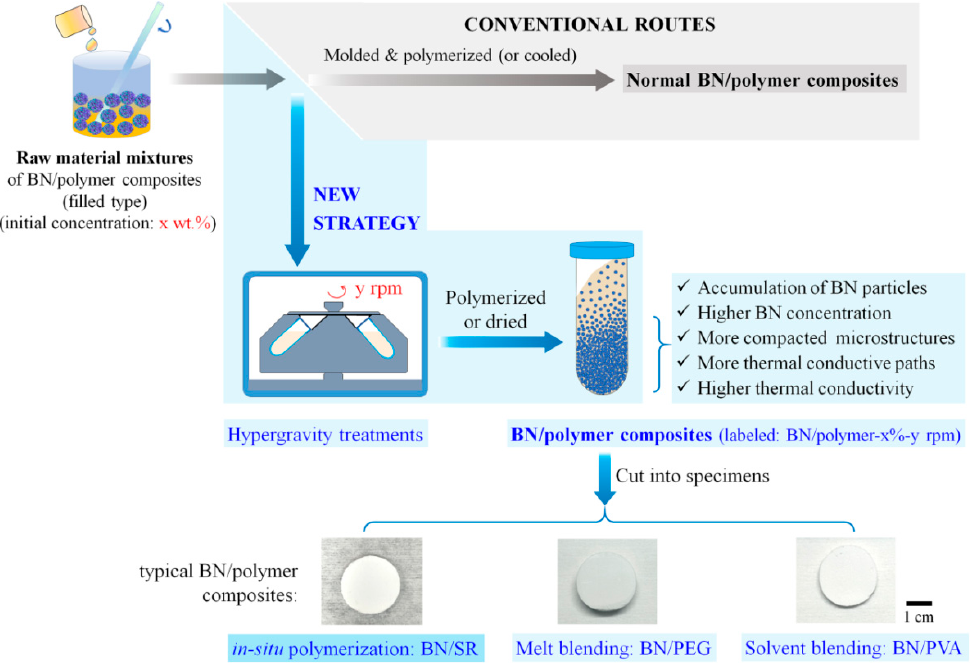
Figure 1. Diagram of the hypergravity accumulation strategy. This new strategy can efficiently improve the thermal conductivity of boron nitride (BN) ‐ filled polymer composites. It is a universal method to be used in different polymers and in various preparation techniques.